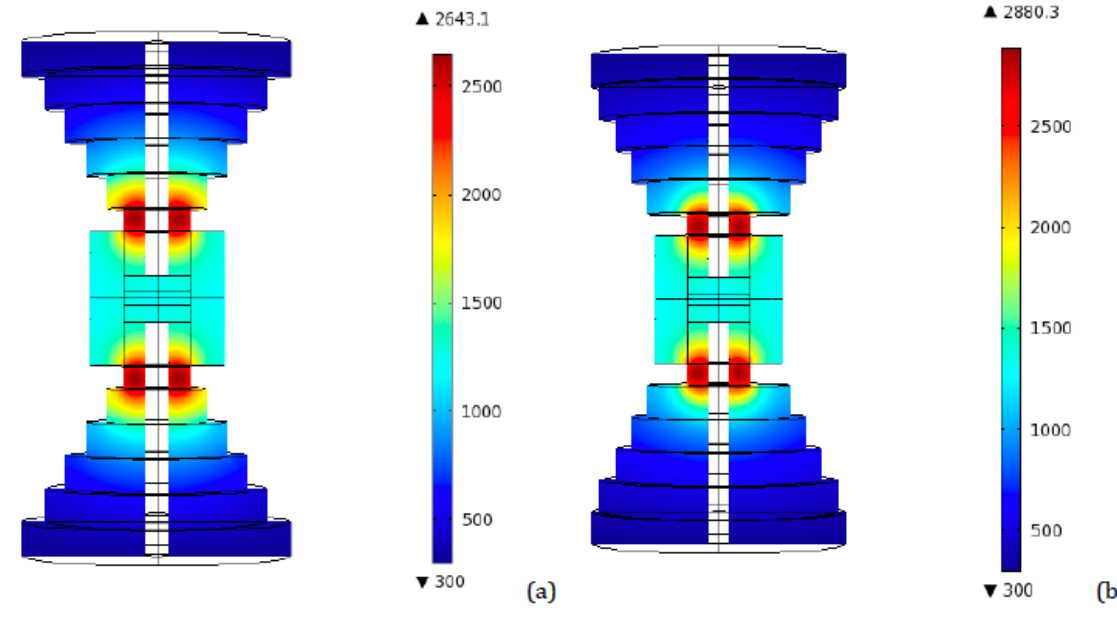
Figure 6. Peak temperature distribution (K)—Ideal contact—four transitional disks configuration. ( a ) Radii: 66, 54, 42, and 30 mm—Heights: 20 mm each; ( b ) Radii: 75, 65, 55, and 45 mm—Heights: 20 mm